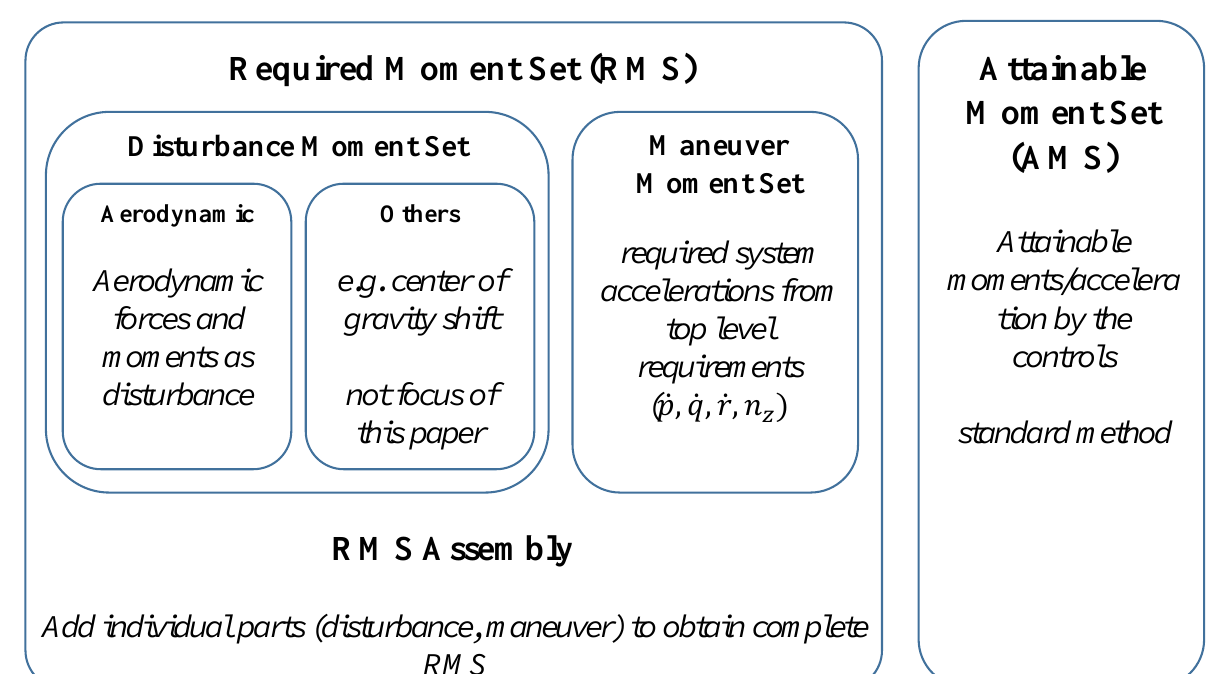
Figure 1. Overview of required and attainable moment sets and the proposed methods for obtaining the required mo- ment